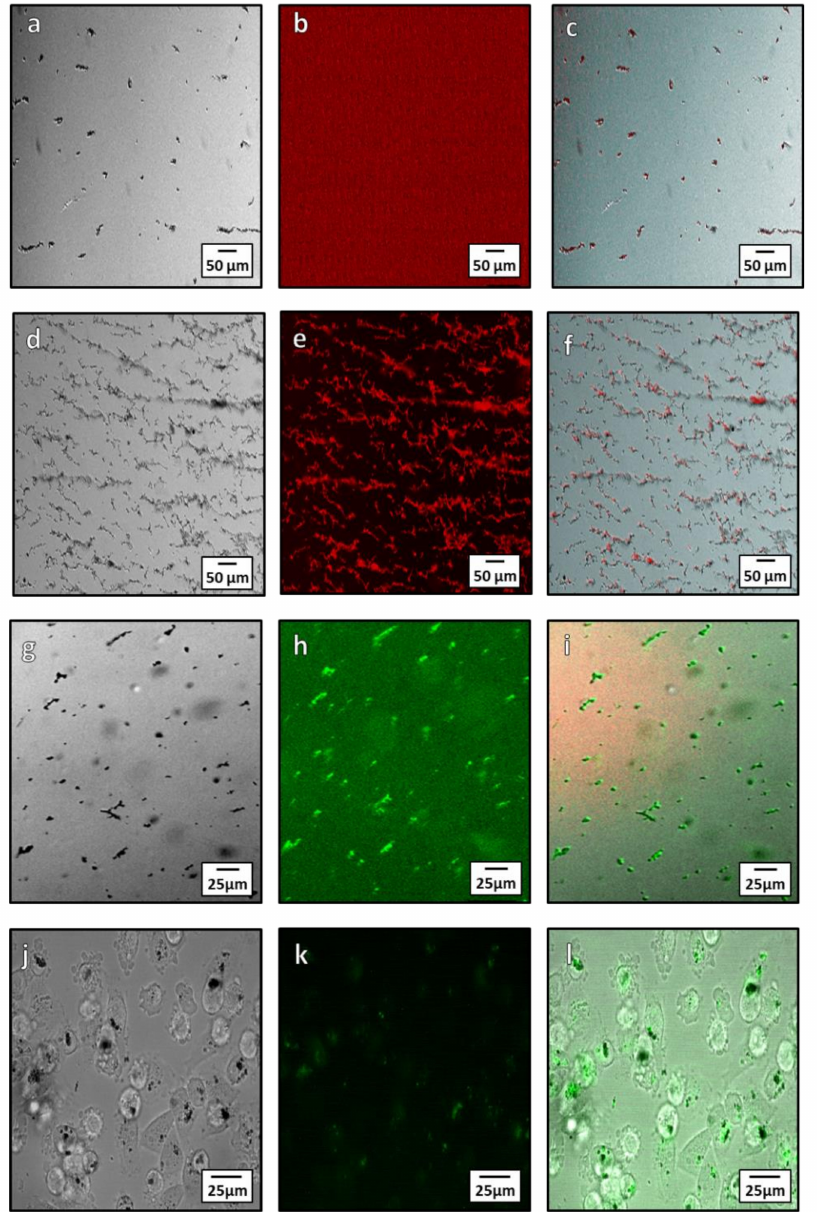
Figure 7. Microscopy showing localization Alexa Fluor ® 594 and 488 with magnetosomes after conju- gation both intra and extracellularly. ( a – c ) unbiotinylated (control with no coupling) magnetosomes treated with streptavidin Alexa Fluor ® 594: ( a ) Brightfield image of unbiotinylated magnetosomes; ( b ) red channel fluorescence showing lack of Alexa Fluor ® 594 fluorescence; ( c ) composite image showing little to no fluorescence bound to the magnetite. ( d – f ) Biotinylated magnetosomes conjugated with Alexa Fluor ® 594: ( d ) bright field image of biotinylated magnetosomes; ( e ) red channel of Alexa Fluor ® 594; ( f ) composite showing localization of the Alexa Fluor ® 594 dye to the magnetosomes. ( g – i ) Microscopy of Alexa Fluor ® 488 streptavidin conjugation to magnetosomes: ( g ) Bright field mi- croscopy of magnetosome; ( h ) green channel fluorescence showing the Alexa Fluor ® 488 streptavidin; ( i ) composite showing conjugation of the Alexa Fluor ® 488 streptavidin to the magnetosomes. ( j – l ) Intracellular Alexa Fluor ® 488 conjugated magnetosome: ( j ) In bright field microscopy; ( k ) fluorescent images of conjugated magnetosomes; and ( l ) a composite of the bright field and fluorescent